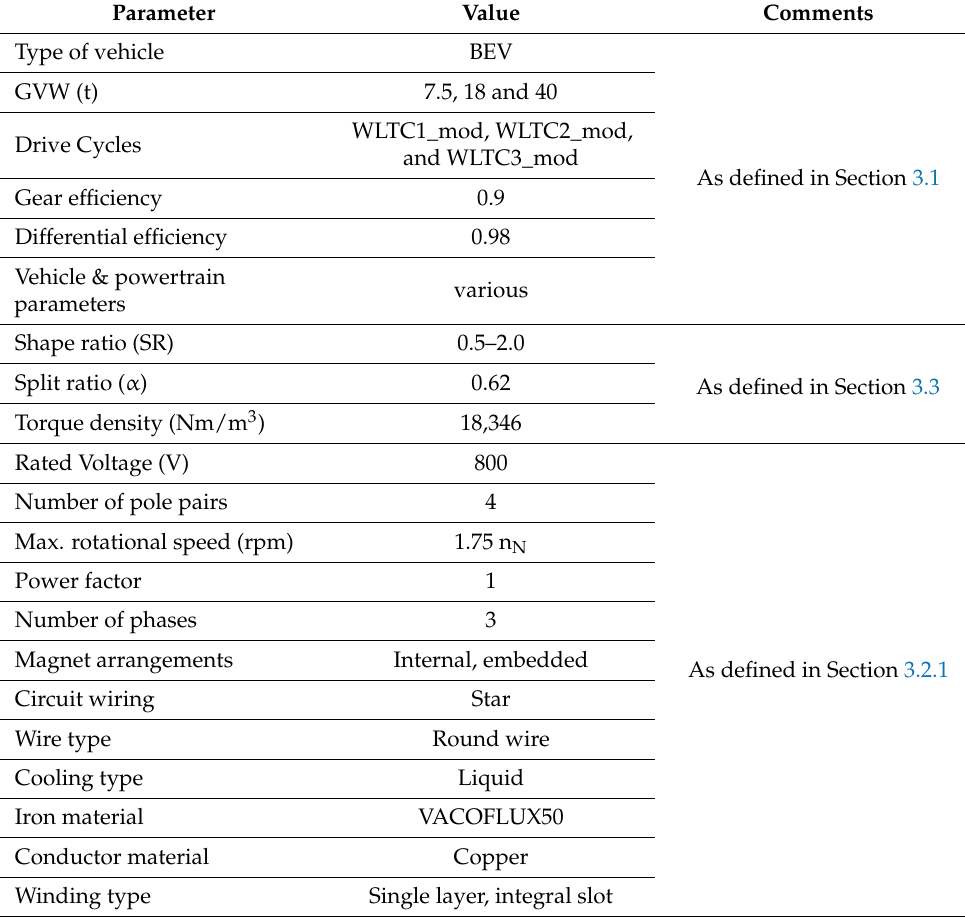
Table 7. Overview of the assumptions and considered parameter